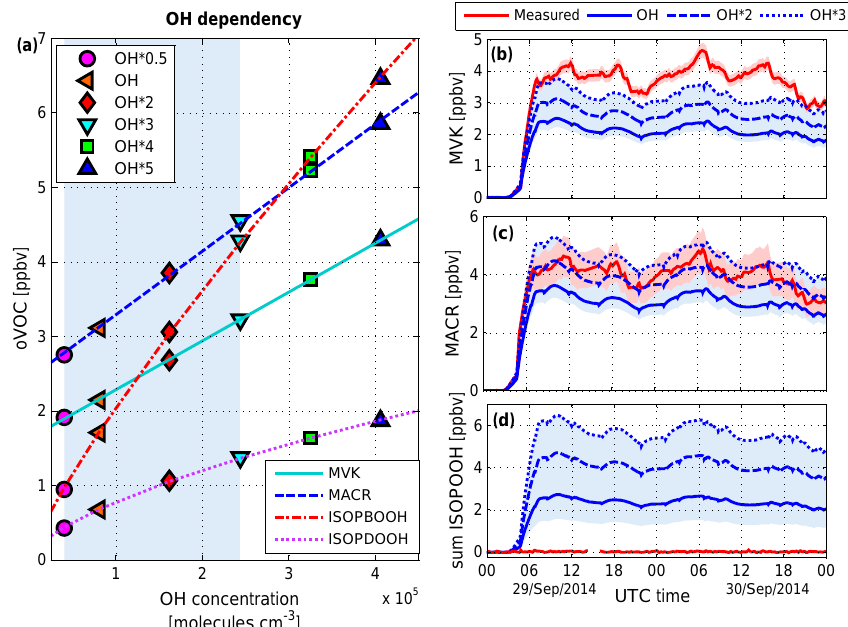
Figure 2. (a) OH dependence of the concentration of the main oxidation products at 263K (run 2), (b) changes in MVK prediction depending on OH concentration in comparison to measured data, (c) changes in MVK prediction depending on OH concentration in comparison to measured data, and (d) changes in ISOPOOH prediction depending on OH concentration. The shaded blue area corresponds to the range of OH concentrations, and the red shaded area corresponds to the uncertainty in the respective measurements of MVK and